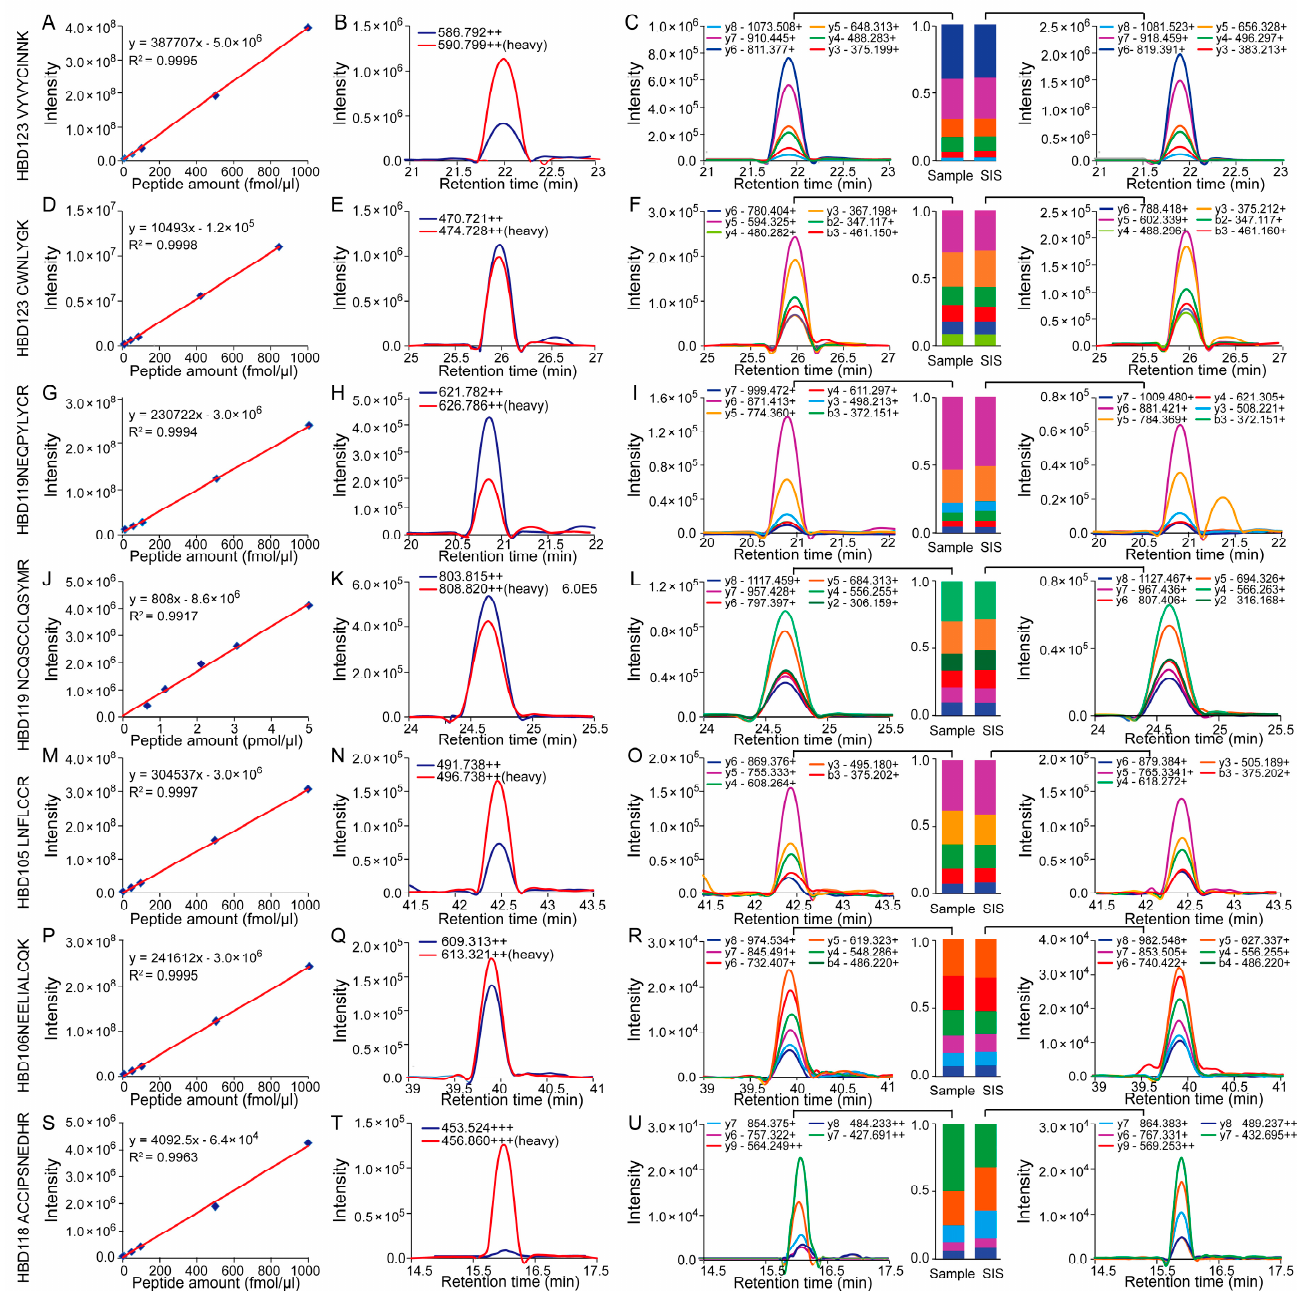
Figure 6. The validation of beta-defensins based on the MRM technique. The linear of the SIS peptides were displayed in the ( A , D , G , J , M , P , S ). The TIC diagrams of the SIS peptides and the endogenous peptides segments were displayed in the ( B , E , H , K , N , Q , T ). The endogenous and SIS peptides were calculated and compared according to the MS2 traces, and showed in ( C , F , I , L , O , R , U